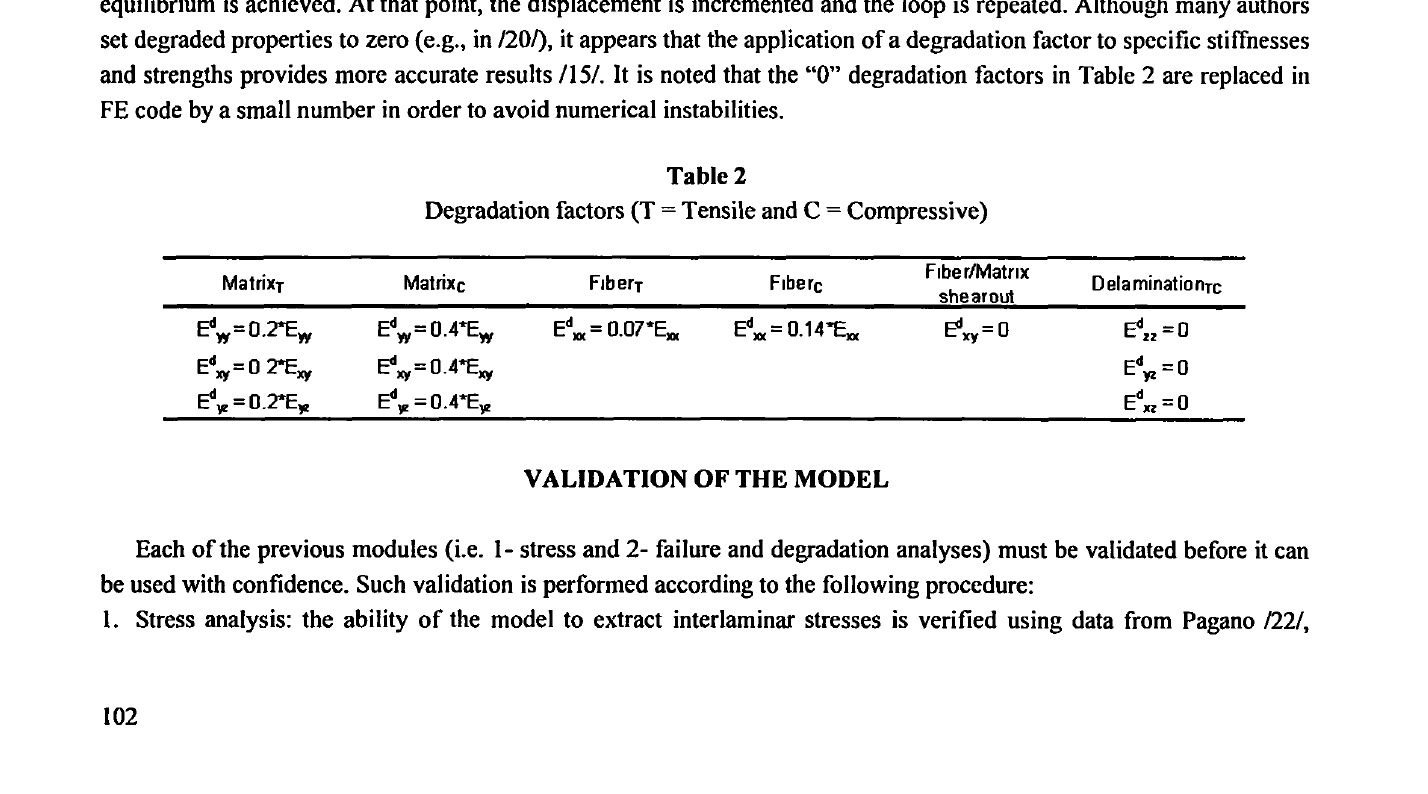
Degradation factors (T = Tensile and C = Compressive)